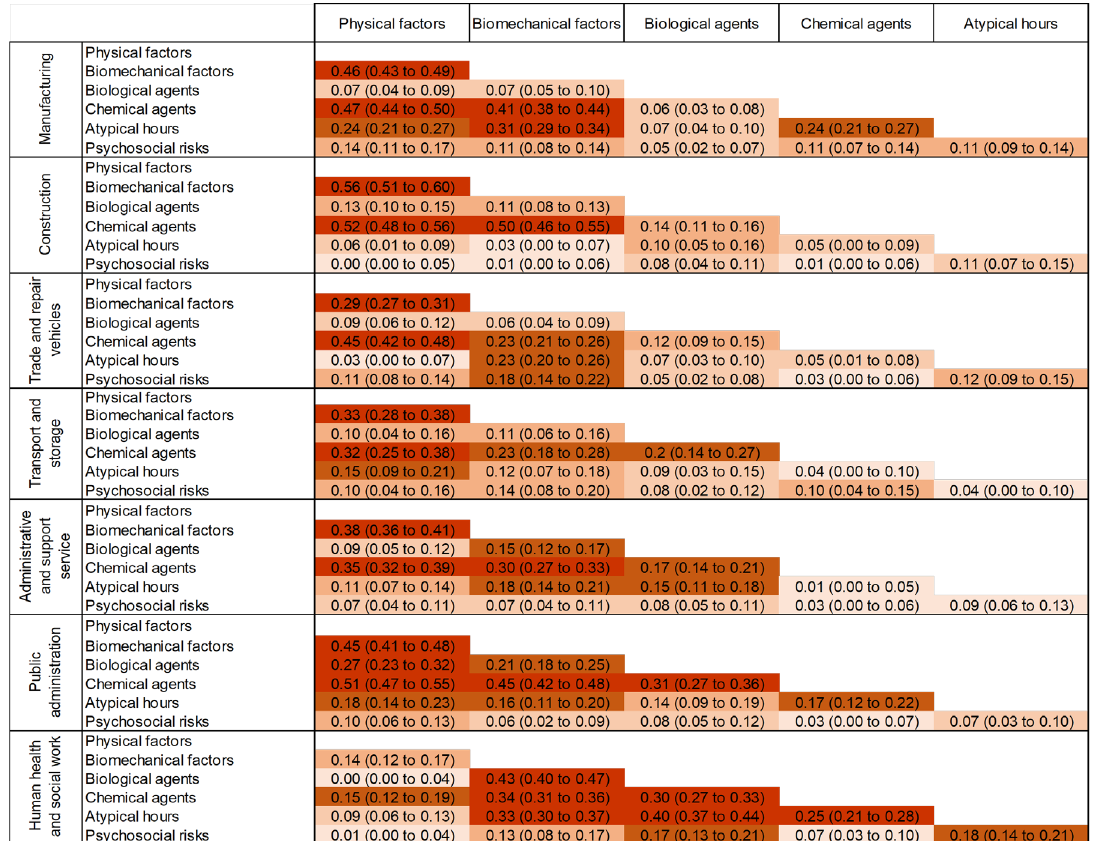
Figure 2. This plot presents a polar representation of the percentage of workers who declared an exposure to a certain risk. The red color represents the percentage of individuals who reported an exposure, while the grey color represents the percentage of individuals who did not report an exposure. On one side of the plot, the declarations are grouped by sector ( left ); on the other side, they are grouped by risk ( right ). * p < 0.05 vs. all other risks/sectors.